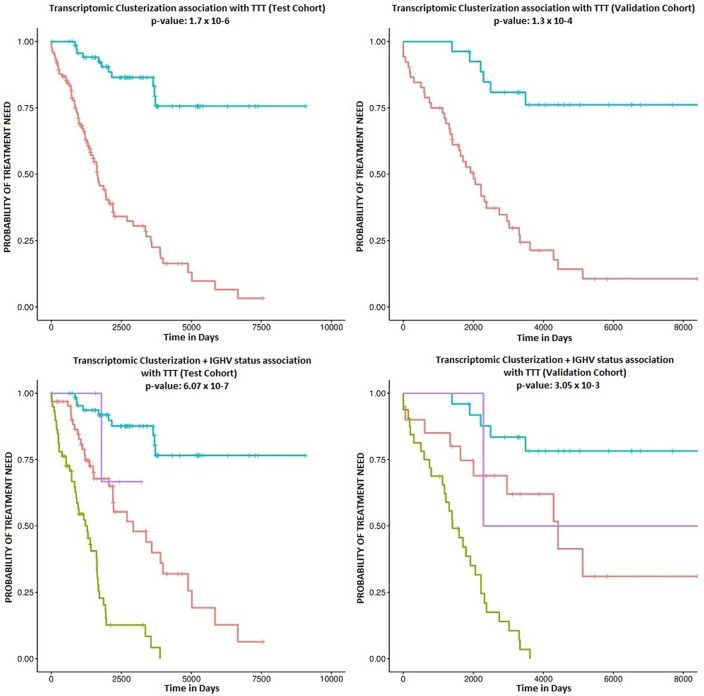
Kaplan-Meier survival plots. The upper plots show the association of C1 (red curve) and C2 (blue curve) with TTT in the study (left) and validation cohorts (right). Corresponding p-values are 1.7 × 10−6 and 1.3 × 10−4. The lower plots show the association with TTT stratified by IGHV mutation status in the study (left) and validation cohorts (right). The blue line indicates C2 samples with mutated IGHV, the purple line indicates C2 samples with unmutated IGHV, the red line indicates C1 samples with mutated IGHV, and the green line refers to C1 samples with unmutated IGHV.